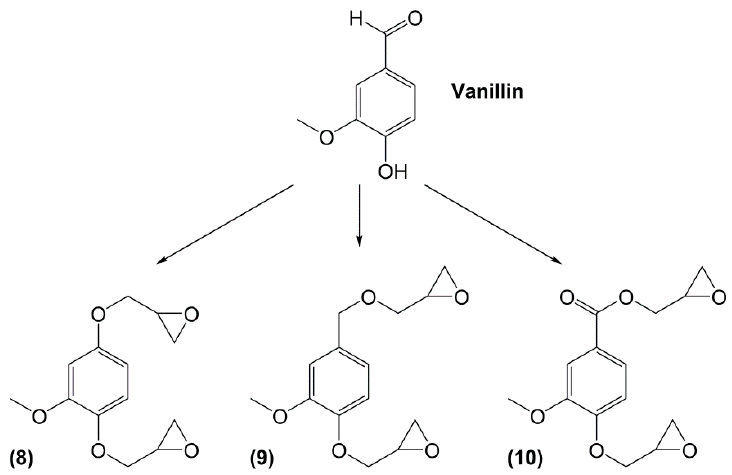
Figure 12. Diglycidyl ether compounds obtained from vanillin: ( 8 ) diglycidyl ether of vanillyl alcohol, ( 9 ) diglycidyl ether of methoxyhydroquinone and ( 10 ) diglycidyl ether of vanillic acid [135].